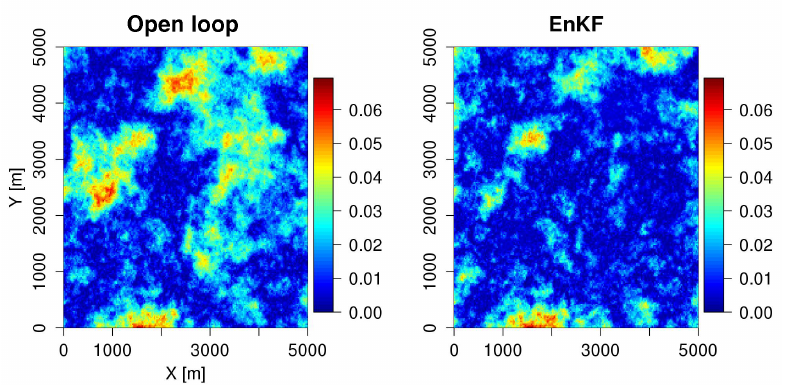
Figure 10. Absolute average error of soil water content AAE θ for open loop (left) and assimilation (right) at a depth of − 65cm from April to June 2013.